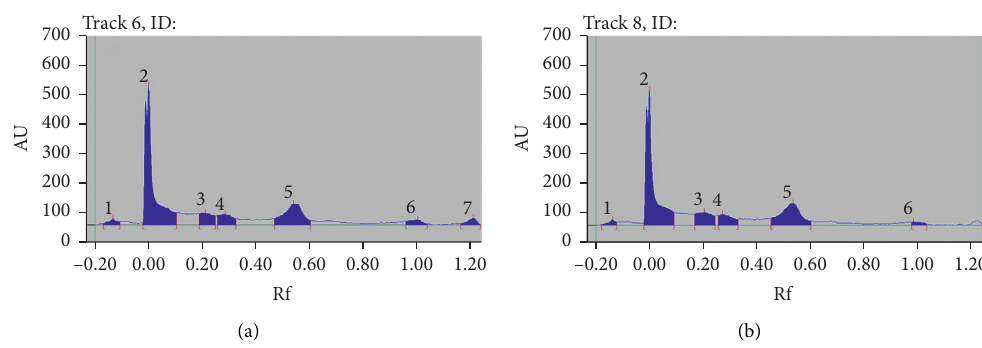
Figure 6: HPTLC fingerprint profile of V. anthelmintica : (a) sample 1 and (b) sample 8.